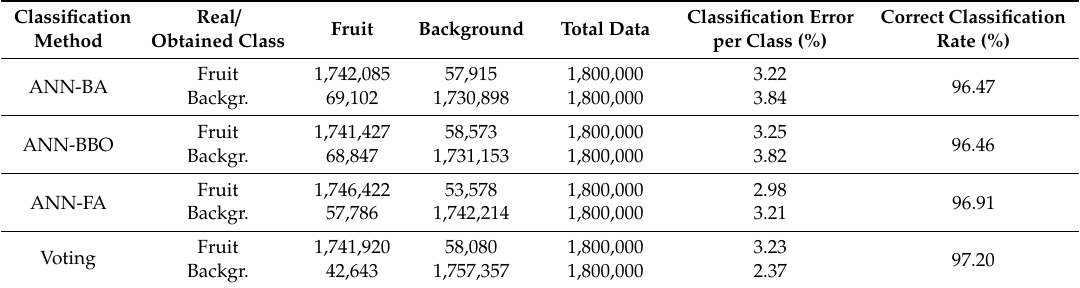
Table 12. Confusion matrices, classification error per class, and correct classification rate (CCR) of di ff erent classifiers for 500 iterations.